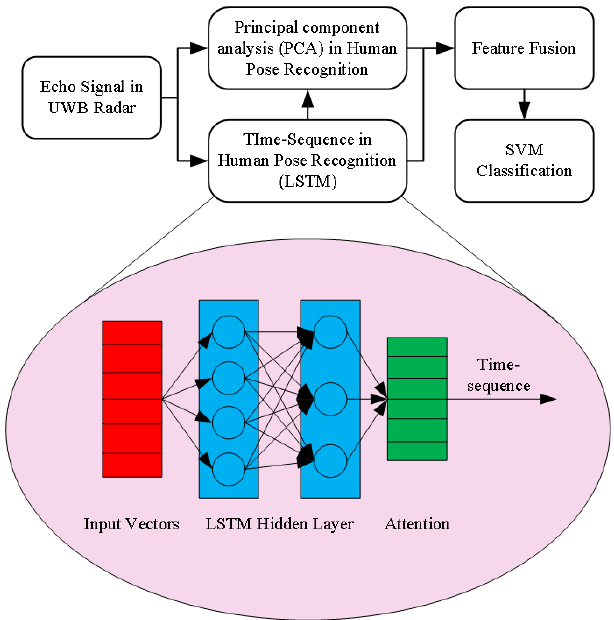
Figure 3. PCA-LSTM dual-channel human pose feature